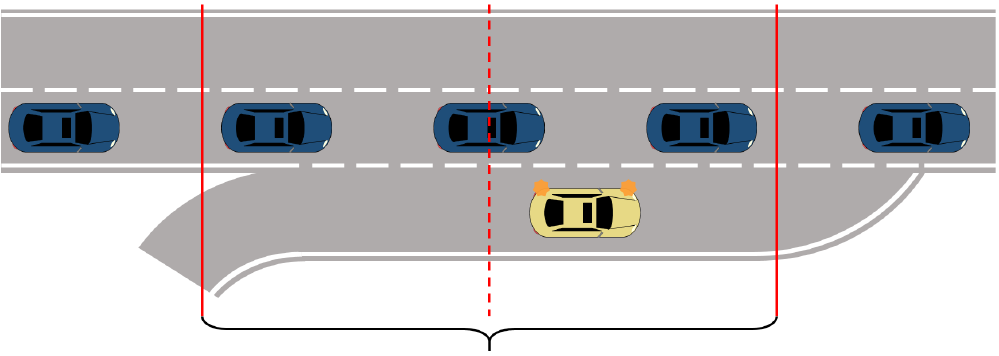
Figure 1. Scenario extraction with four